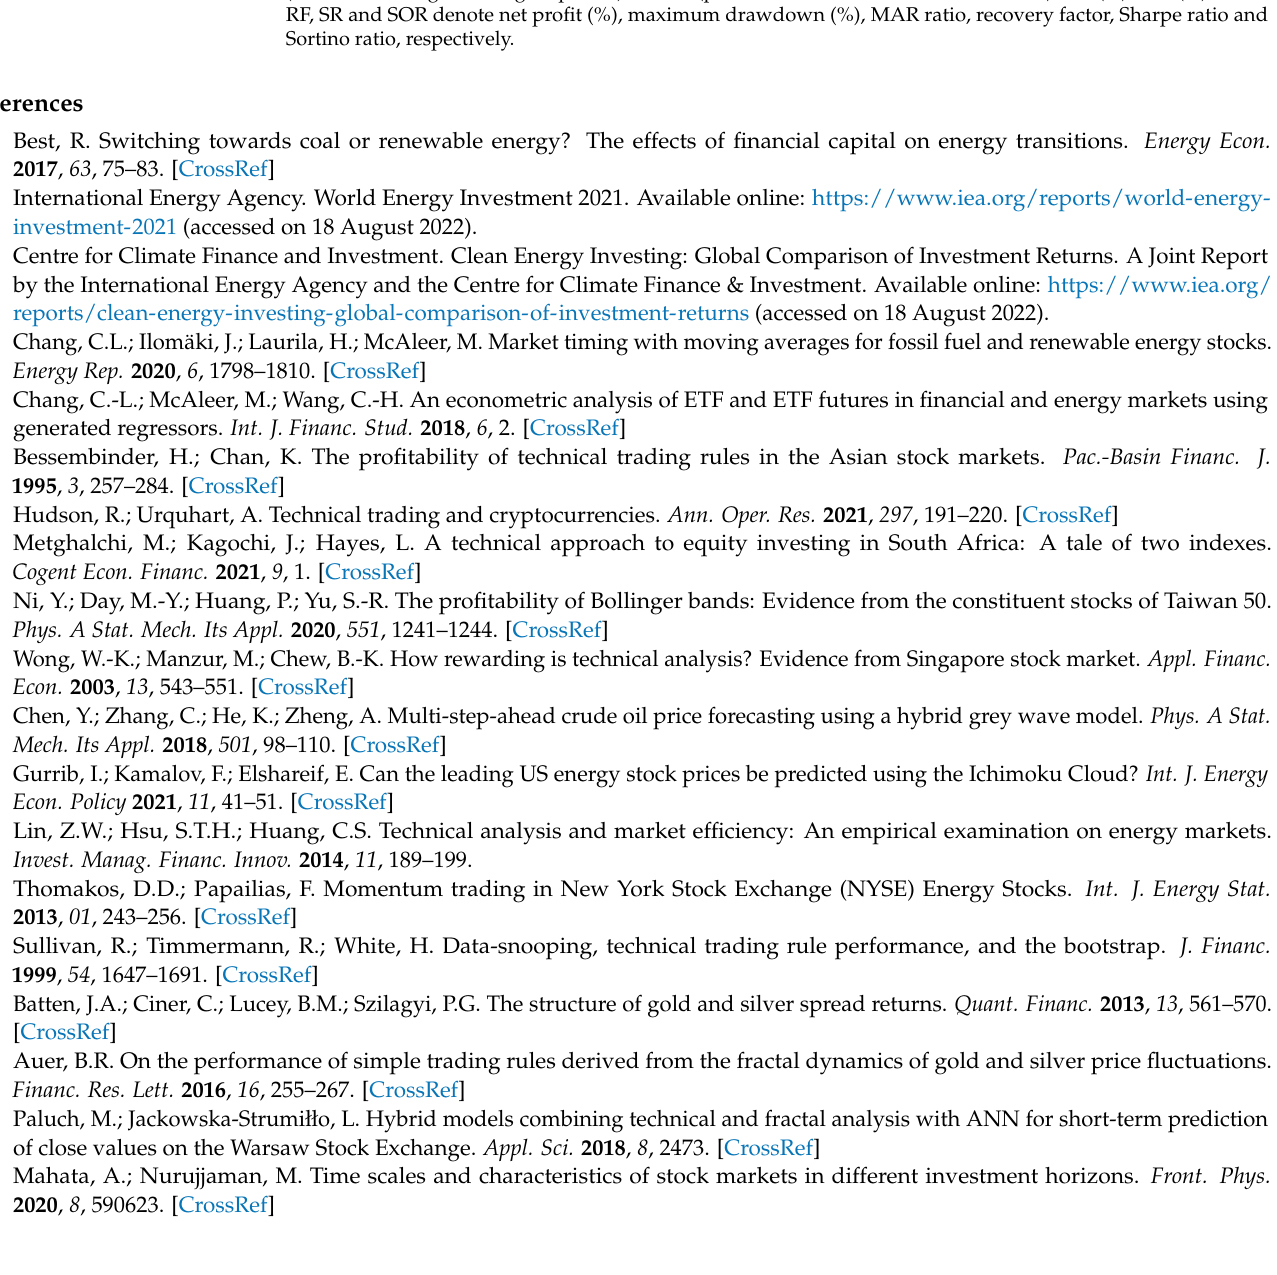
indicate the worst, second worst and third worst outcomes, respectively. The parameters are described as MACD (short EMA, long EMA, signal period) and BB (period, number of standard deviations). NP (%), MD (%), MAR, RF, SR and SOR denote net profit (%), maximum drawdown (%), MAR ratio, recovery factor, Sharpe ratio and Sortino ratio,